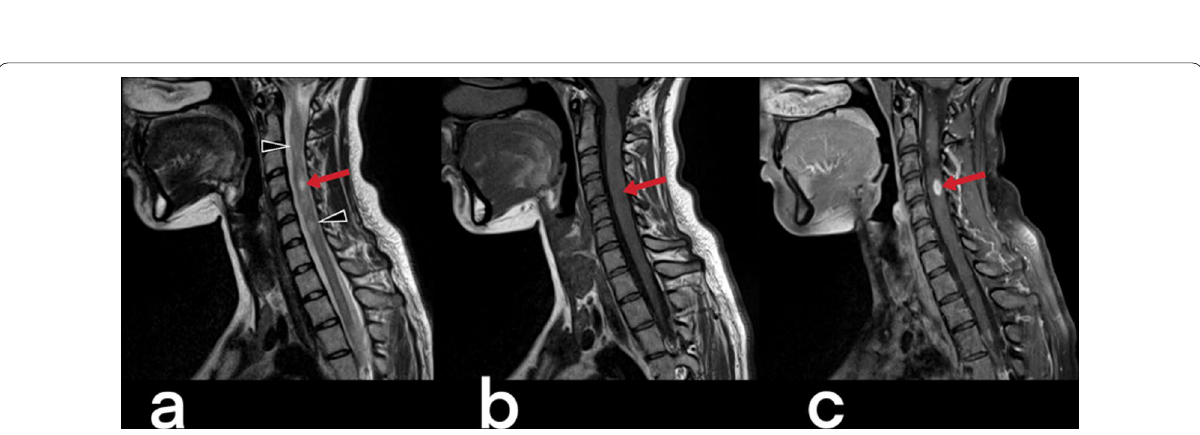
Fig. 7 MR images of a 17-year-old female with the diagnosis of cervical tuberculous myelitis. Sagittal T2 weighted image ( a ) shows a heterogeneous increased signal (edema, inflammation) on the spinal cord (arrowheads) and focus (arrow). The cervical spinal cord is observed as an enlarged diffuse hypointense area on pre-contrast T1-weighted image ( b ). Post-contrast ( c ) T1 weighted image reveals diffuse heterogeneous and focal (arrow) contrast enhancement of the same region. The focus is a tuberculoma